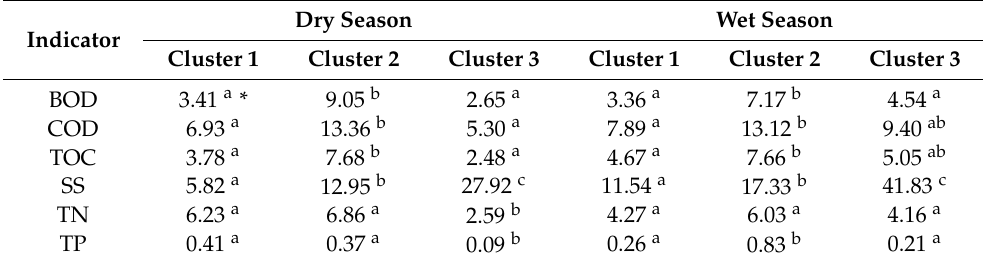
Table 2. Mean value (mg/L) of water quality according to season and